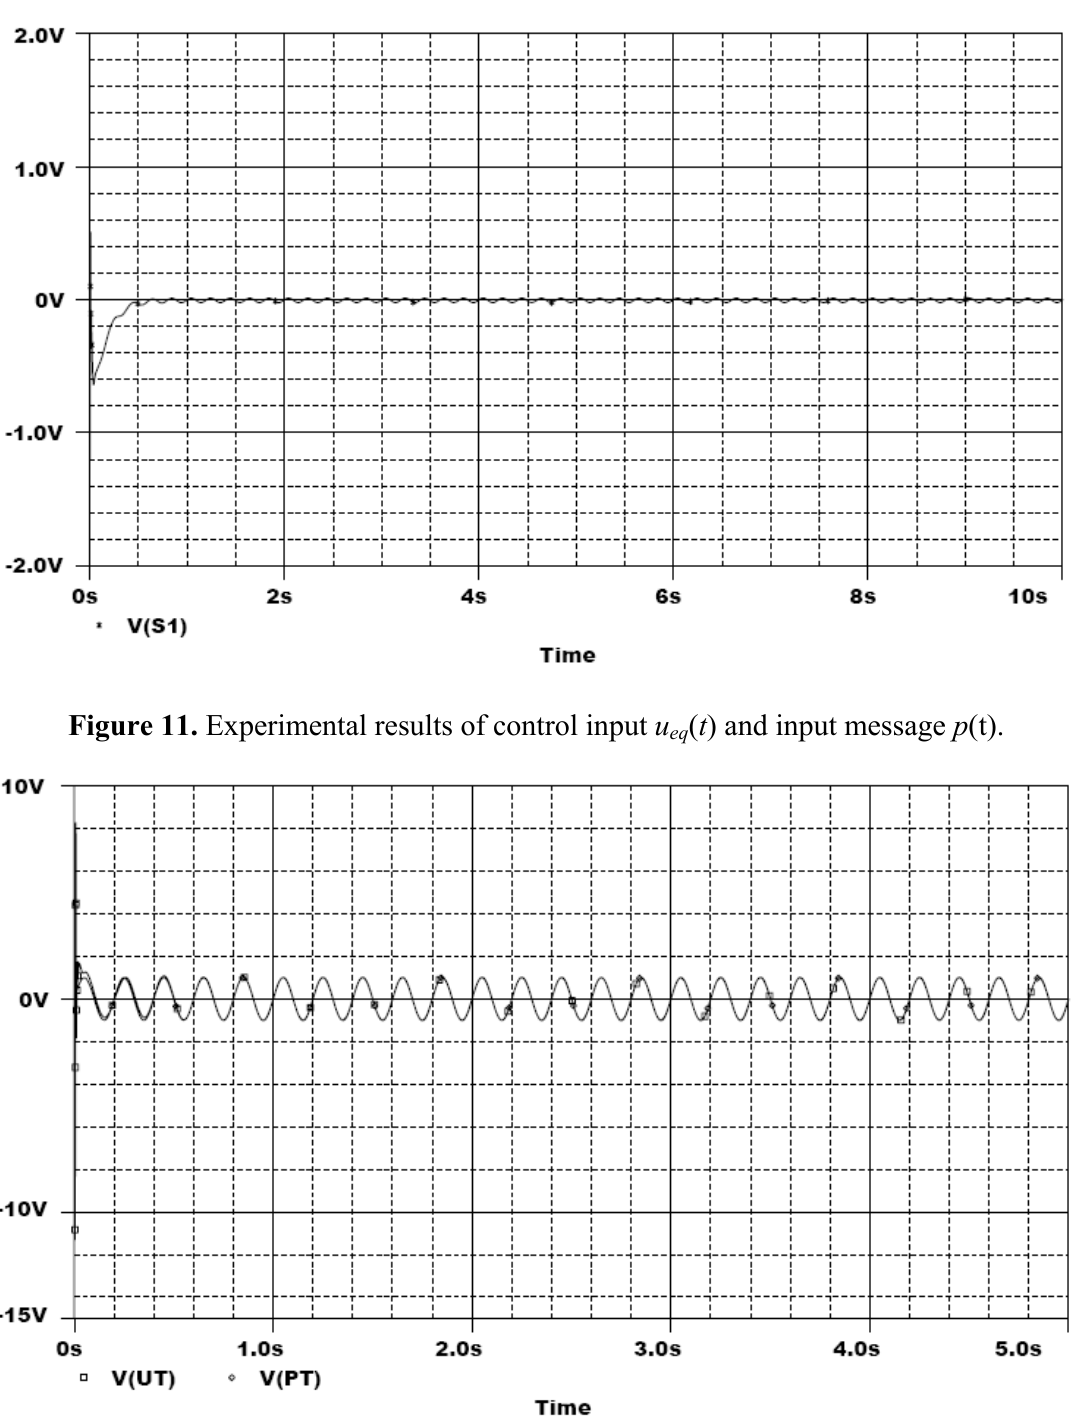
Figure 10. Experimental result of switch surface s (t).